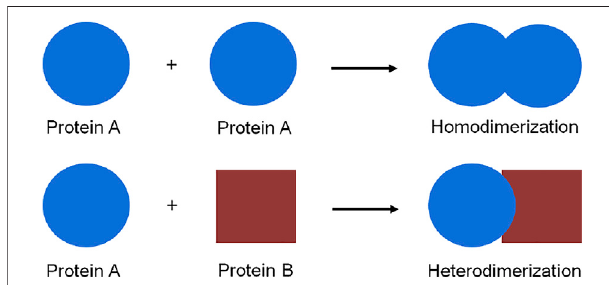
FIGURE 1 | Schematic representation of protein homo-and hetero- dimerization.